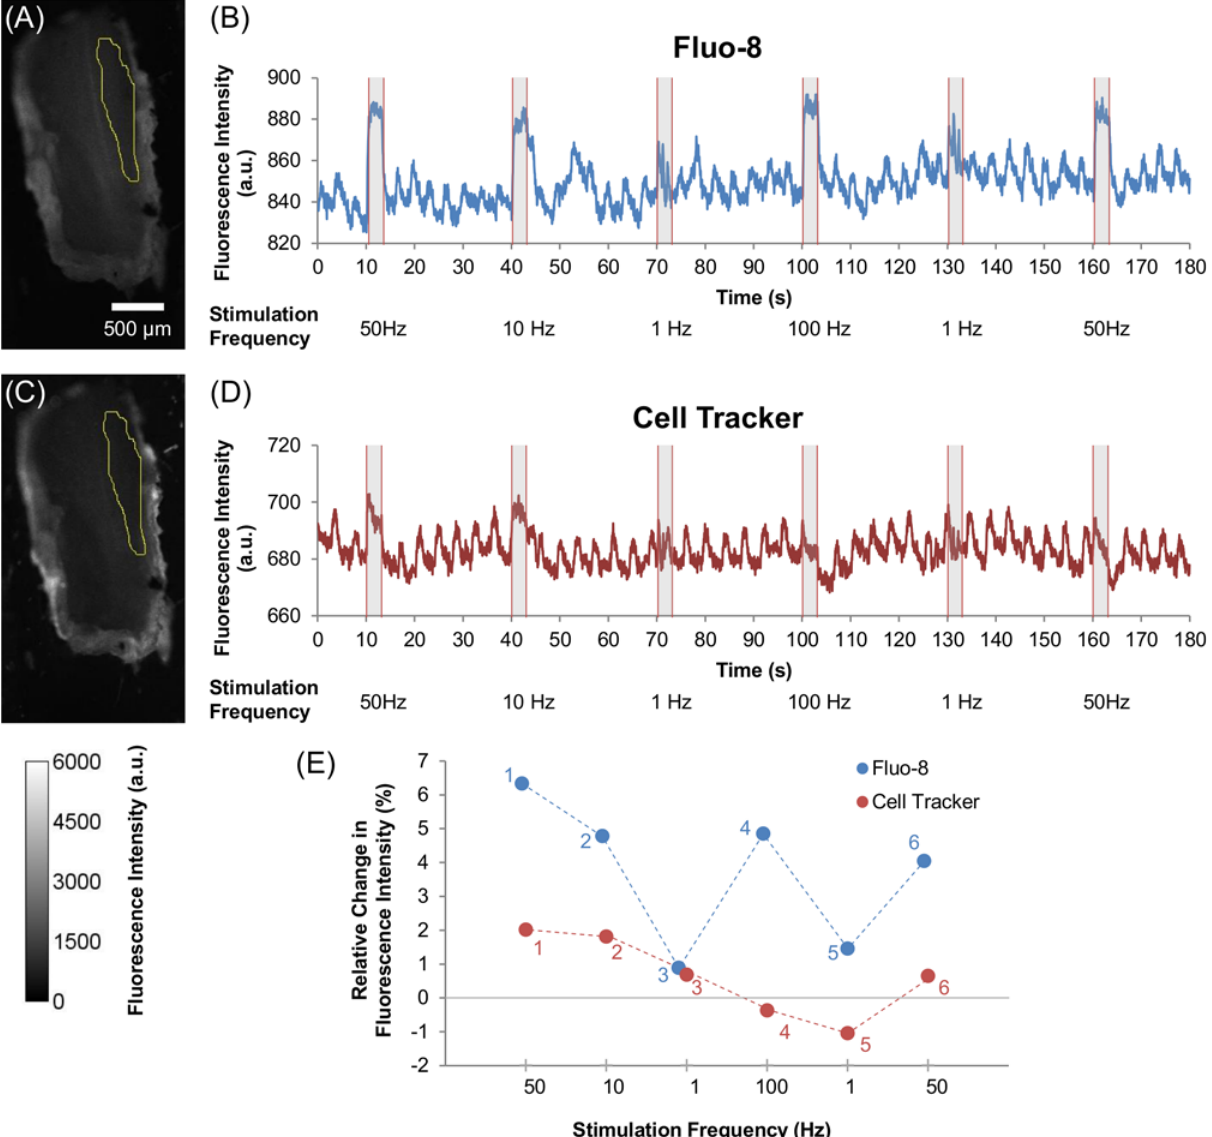
Figure 4. Effect of various electrical stimulation frequencies on Ca 2+ dynamics and muscle displacement in beetle leg muscle. Images of beetle leg muscle that was dosed with (A) Fluo-8 (60 µ M) and (C) Cell Tracker (60 µ M), with the yellow selection indicating the ROI that was used for analysis (as also shown in S1B Fig.). The color scale is given at the bottom left corner of the image. Representative time courses showing the fluorescence intensity dynamics of (B) Fluo-8, and (D) Cell Tracker under various electrical stimulations of multiple pulse trains (50 Hz, 10 Hz, 1 Hz, 100 Hz, 1 Hz, and 50 Hz; 10% duty cycle; 2 V) observed from the ROI that are displayed in (A) and (C) respectively. All electrical stimulations were applied for 3 seconds periods with a 27 seconds resting period in between stimulations. The stimulus timing is indicated by grey shading. (E) Relative change in fluorescence intensity (( Δ F / F 0 )×100%) for Fluo-8 (blue) and Cell Tracker (red) under varying electrical stimulation frequencies (50 Hz, 10 Hz, 1 Hz, 100 Hz, 1 Hz, and 50 Hz; 10% duty cycle; 2 V). The small numbers next to each plot indicate the order of stimulation; i.e., first from 50 Hz followed by varying frequency pulses (10 Hz, 1 Hz, 100 Hz, 1 Hz, and 50 Hz). The Fluo-8 intensity plot shows that Ca 2+ dynamics are dependent on electrical stimulation frequency, whereas the Cell Tracker plot shows that the muscle displacement contributes a small